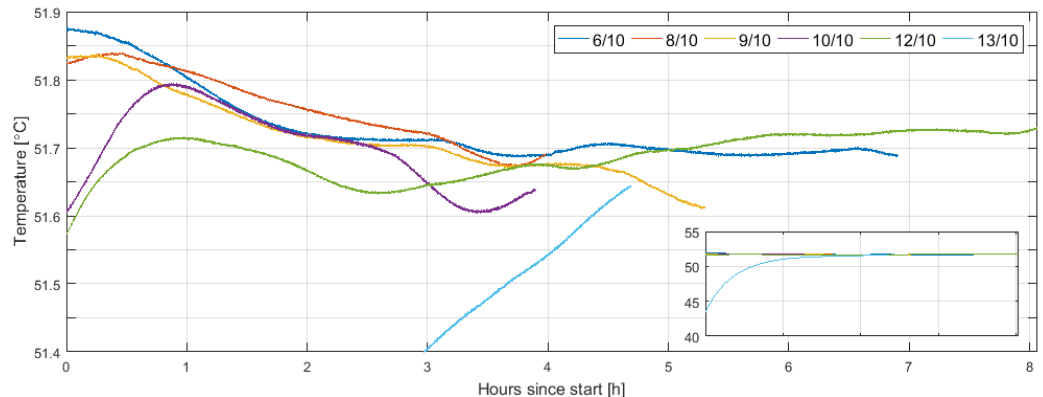
Figure 4. Temperature profile from the six survey days. The small inset has the same x -axis as the larger figure and shows the full temperature span of profiles. Legend shows the date of data